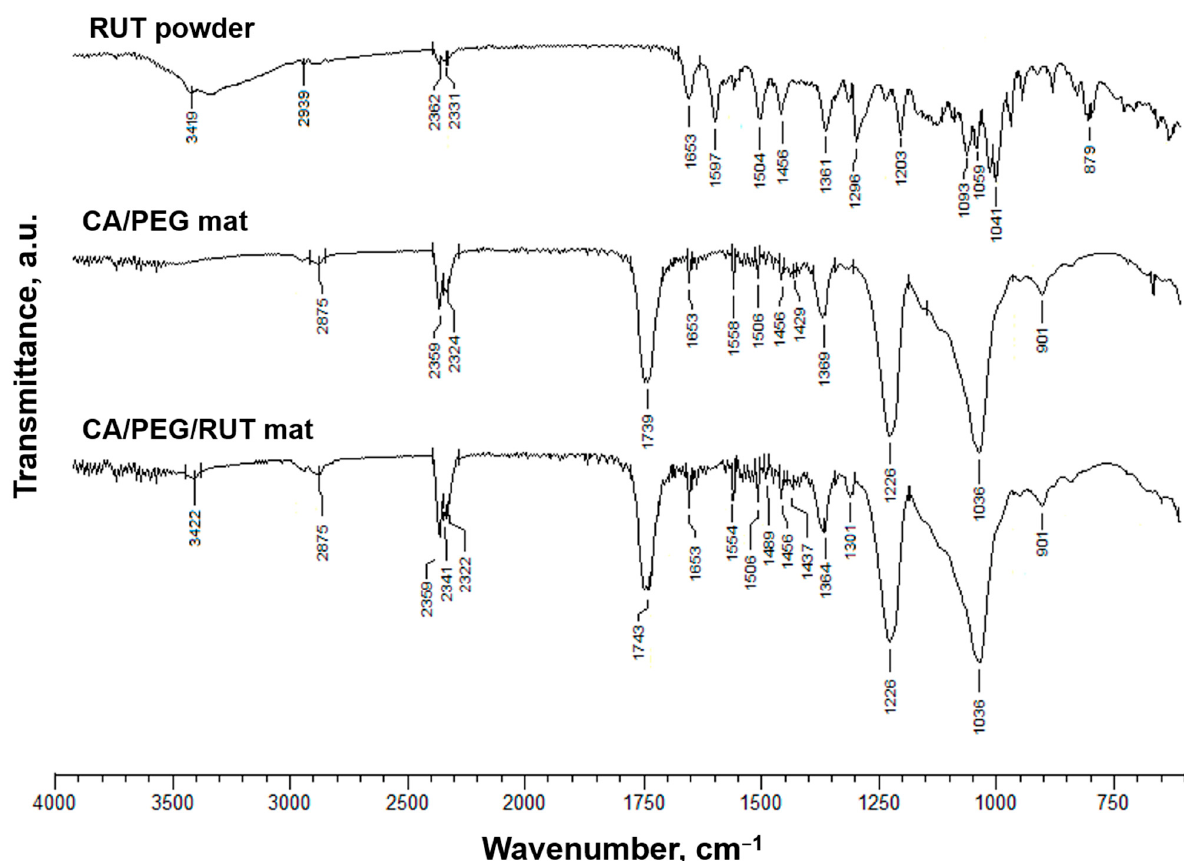
Figure 2. ATR-FTIR spectrum of rutin (powder), CA/ PEG fibers, and CA/ PEG/RUT fibers.